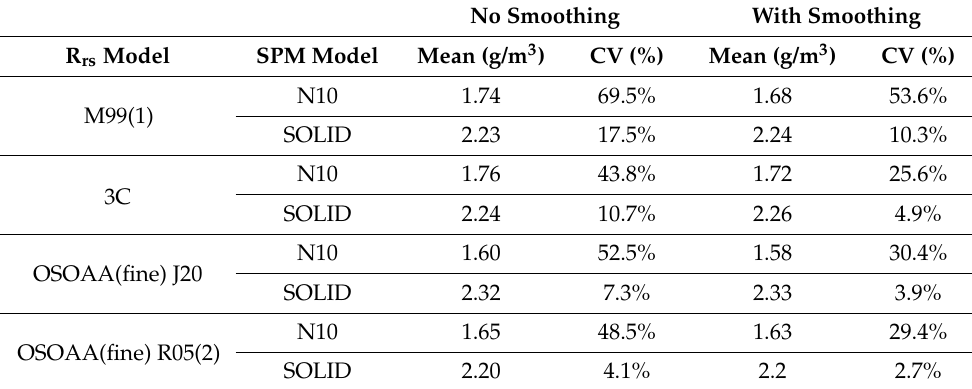
Table 2. Coefficient of variation and mean of SPM values obtained using different R rs spectra and SPM inversion models. No Smoothing With Smoothing R rs